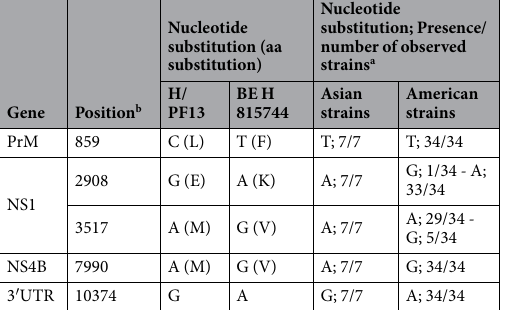
Table 1. Non-synonymous substitutions between PF13 and BE H 815744, and the distribution of these substitutions in strains from America and Asia. a We selected strains for which the complete genome was available in NCBI and that were collected in epidemic countries (to avoid imported cases; strains collected in China and Japan were not included) in America and Asia after 2010. See Table S3 for detail. b Position was defined according to